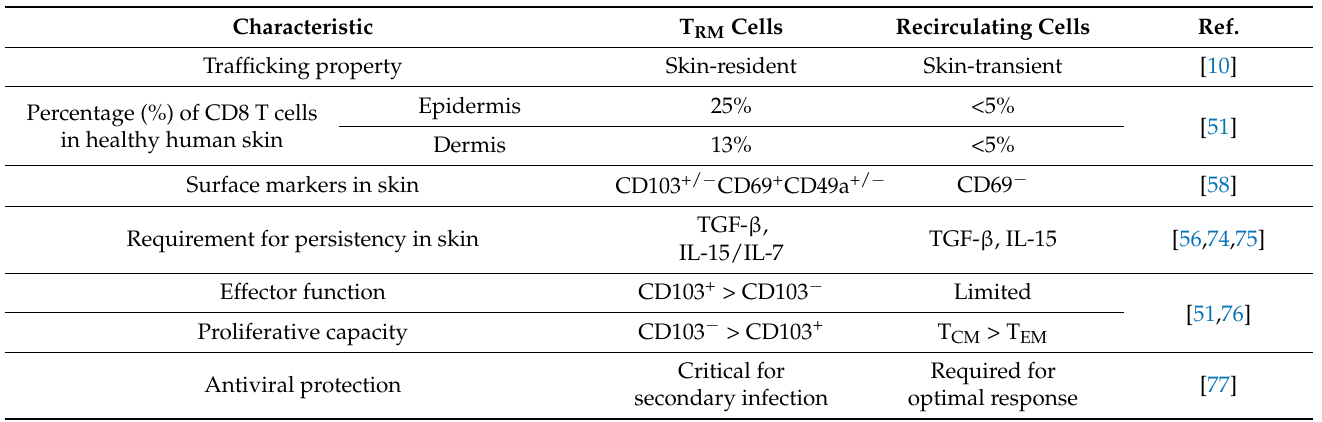
Table 1. Characteristics of skin T RM and recirculating CD8 T